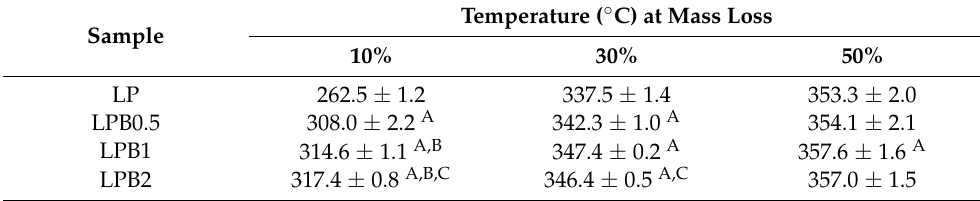
Table 2. TG data for studied PLA-based films.